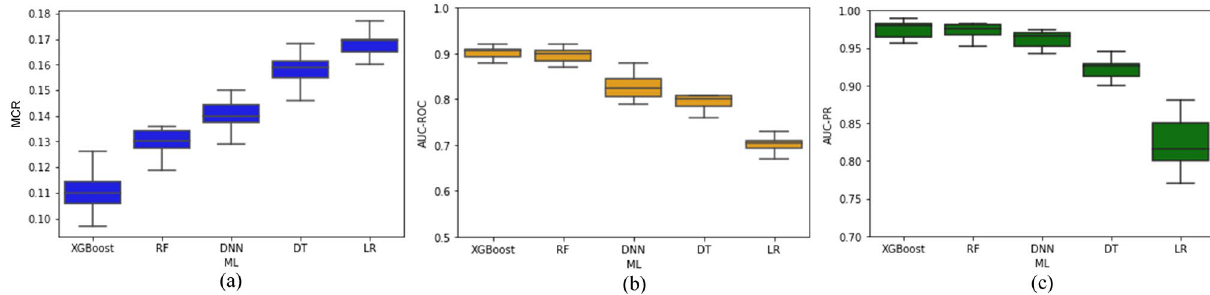
Figure 2. Performance of ML models during tenfold cross-validation procedure.